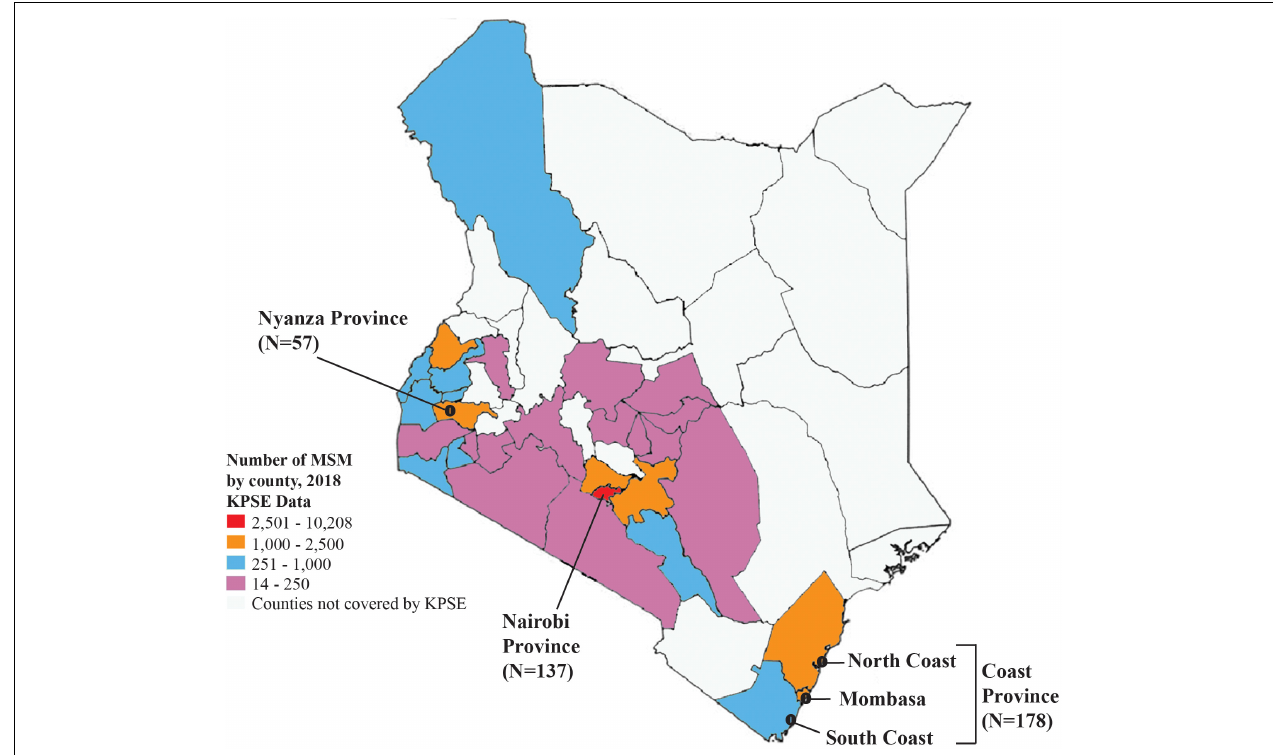
FIGURE 1 | Map of Kenya showing the distribution of sequences in this study. A map of Kenya showing the number of HIV-1 sequences from MSM analyzed in this study, and distribution by different geographic regions. The map is colored based on the estimated number of MSM as mapped at the county level during the 2018 key population size estimates national survey (National AIDS and STI Control Programme [NASCOP],